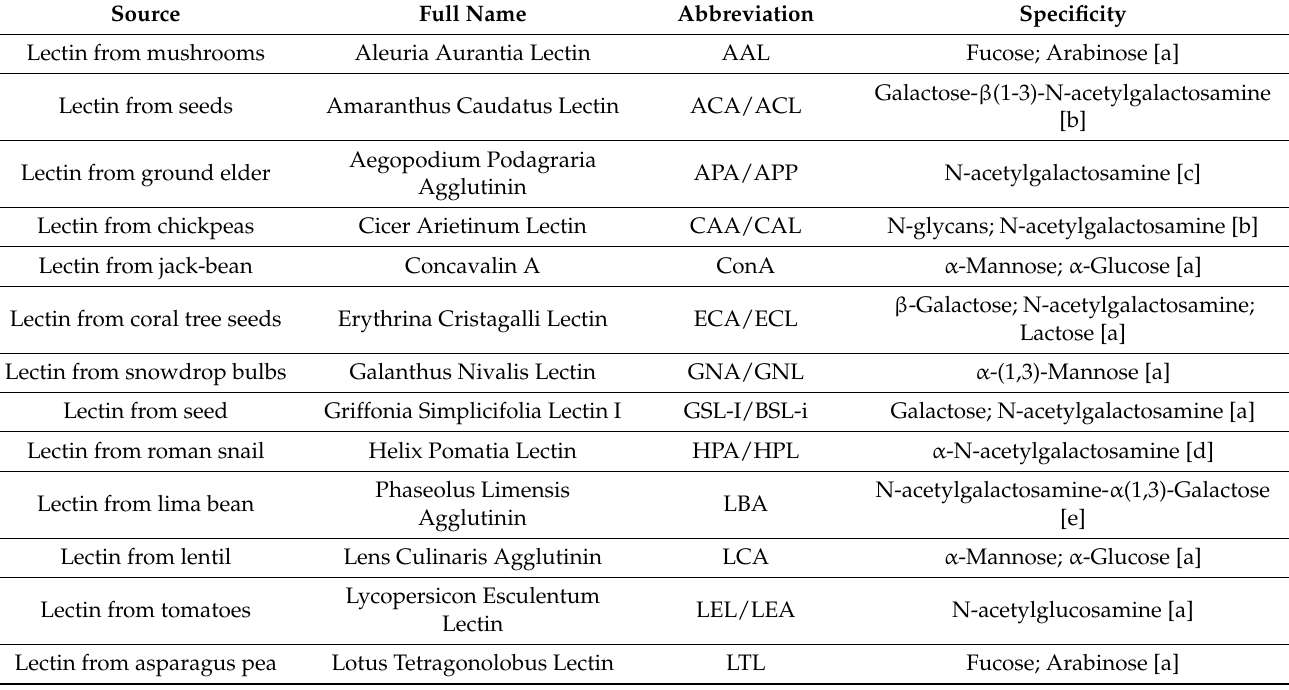
Table 2. List of lectins for the characterization of monosaccharides and disaccharides in biofilm